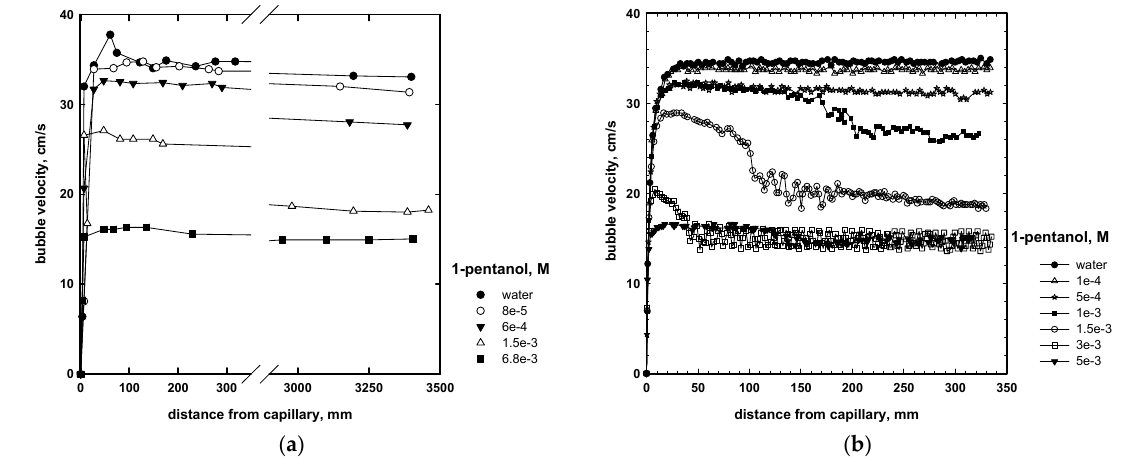
Figure 2. Bubble velocity profiles in the presence of 1-pentanol in McGill ( a ) and PAS ( b ) columns.